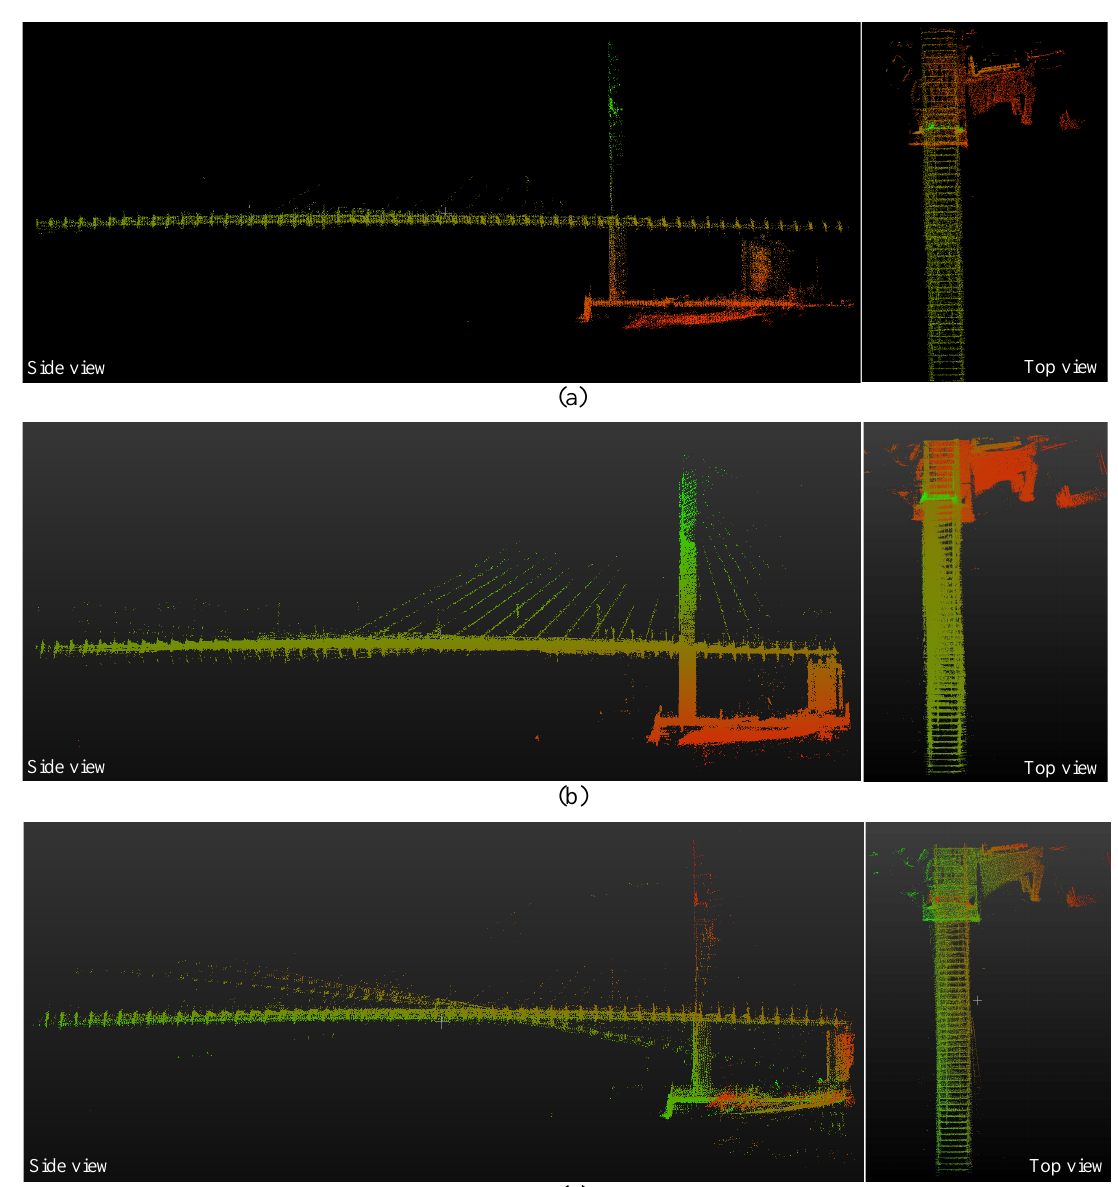
Figure 12. Top and side views of the final 3D maps of Geobukseon Bridge obtained using our method vs. LOAM vs. LIO-mapping: ( a ) Our method, ( b ) LOAM, and ( c )